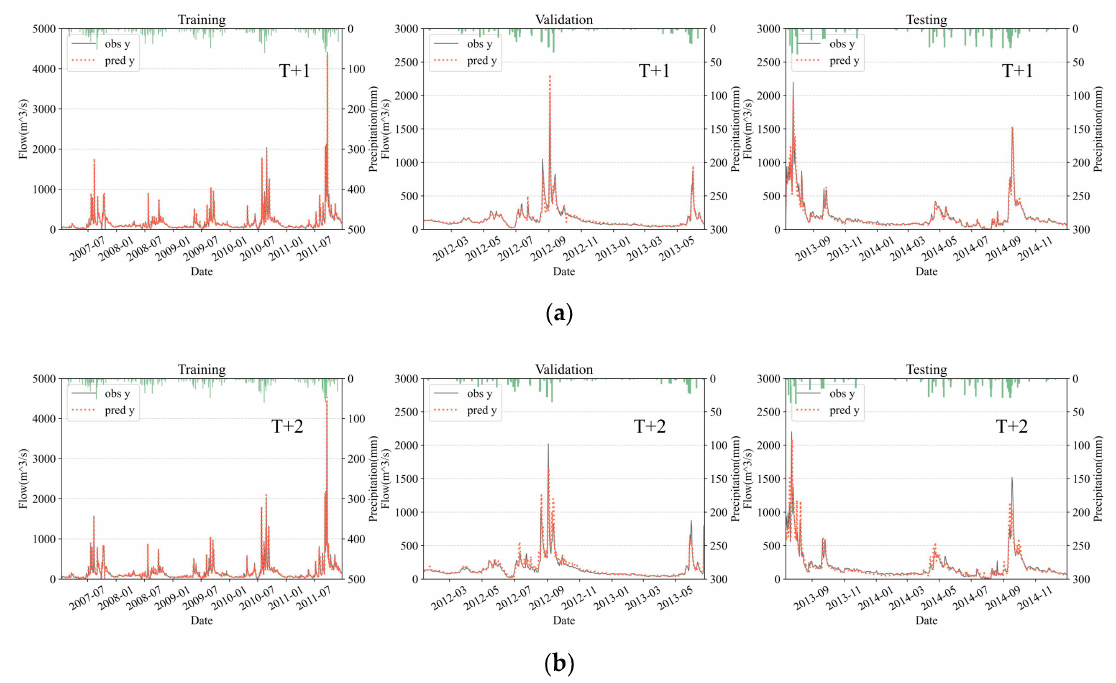
Figure 9. Hydrographs of the forecasting results for the best models. The green bars represent the rainfall data at the Pucheng meteorological station. ( a ) Hydrograph of one-day-ahead (T + 1) forecasting in the training, validation, and testing stage; ( b ) Hydrograph of two-day-ahead (T + 2) forecasting in the training, validation, and testing stage.